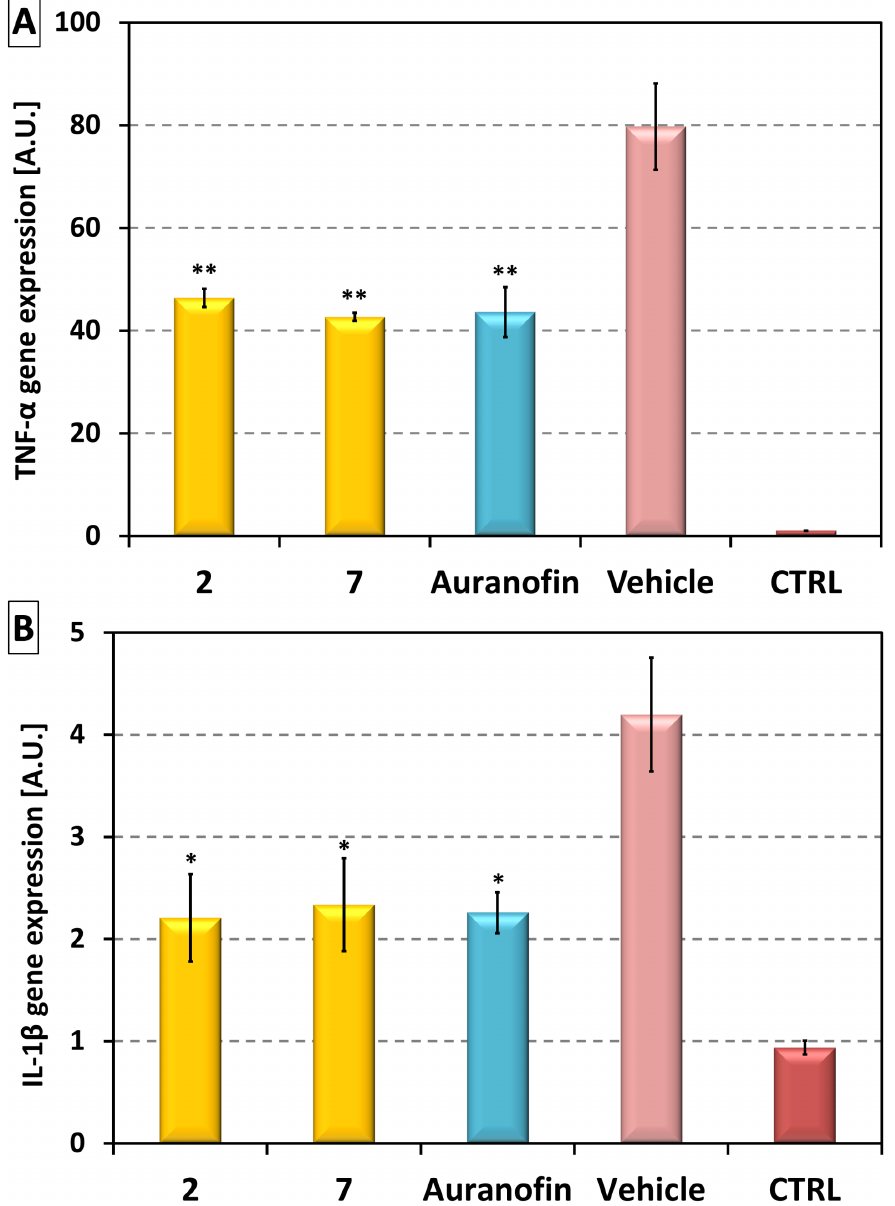
Figure 7. Effects of the Au(I) complexes 2 and 7, and reference drug Auranofin on gene expression of TNF- a (A) and IL-1 b (B). THP-1 macrophages were pretreated with complexes 2 , 7 and Auranofin at the concentration of 300 nM or the vehicle (0.1% DMSO) only. After 1 h of the incubation, the inflammatory response was induced by LPS [except for the control cells (CTRL)]. After 2 h, the level of TNF- a and IL-1 b mRNA was evaluated by RT-qPCR. The amount of cytokine mRNA was normalised to b -actin mRNA. The results are expressed as means 6 SE of three independent experiments. A.U. =arbitrary unit. Significant difference in comparison to: *vehicle-treated cells (p , 0.05), **vehicle-treated cells (p , 0.01). doi:10.1371/journal.pone.0107373.g007 tures are depicted in Figure 3, and 4, respectively. Crystal data and structure refinement parameters (Table S1 in File S1), selected bond lengths and angles (Table S2 in File S1), as well as non- covalent interaction parameters (Tables S3 and S4 in File S1) are given in File S1.